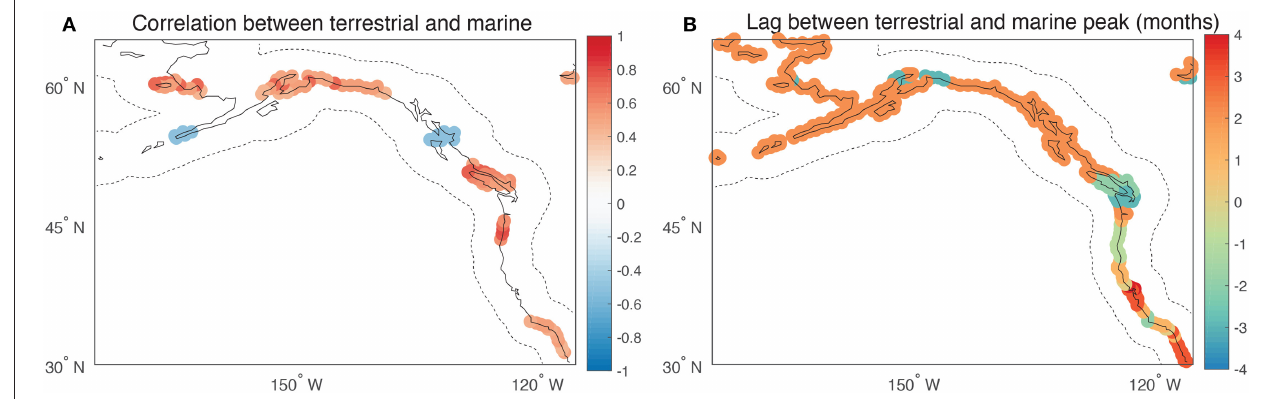
FIGURE 8 | (A) Map showing the correlation coefficient between adjacent ( ± 300 km as contained by the dotted lines) swaths of land (SIF) and sea (chlorophyll). Points are only plotted where the p-value of the correlation is < 0.1. (B) The lag between when adjacent land and sea regions reach their peak in productivity with units of month. The scale of regions used in the calculation are identical to those used in (A) . The calculation of when the peak in productivity occurred is as shown in Figure 2